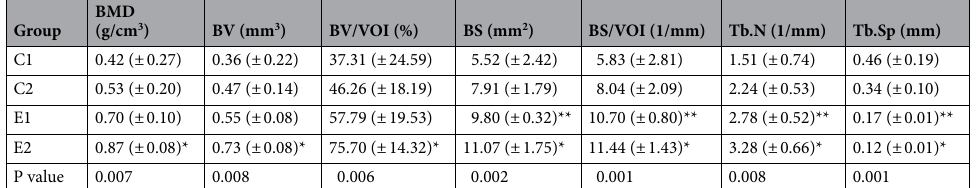
Table 6. Micro-CT morphometric parameters of the bone regeneration area in 3D analysis. The data is depicted as mean ± standard deviation (SD) BMD bone mineral density, BV bone volume, BV/VOI bone volume/volume of interest, BS bone surface, BS/VOI bone surface/volume of interest ratio, Tb.N trabecular number, Tb.Sp trabecular spaces. * p < 0.05, E2 group versus the C1 group. ** p < 0.05, E1 group versus the C1 group.